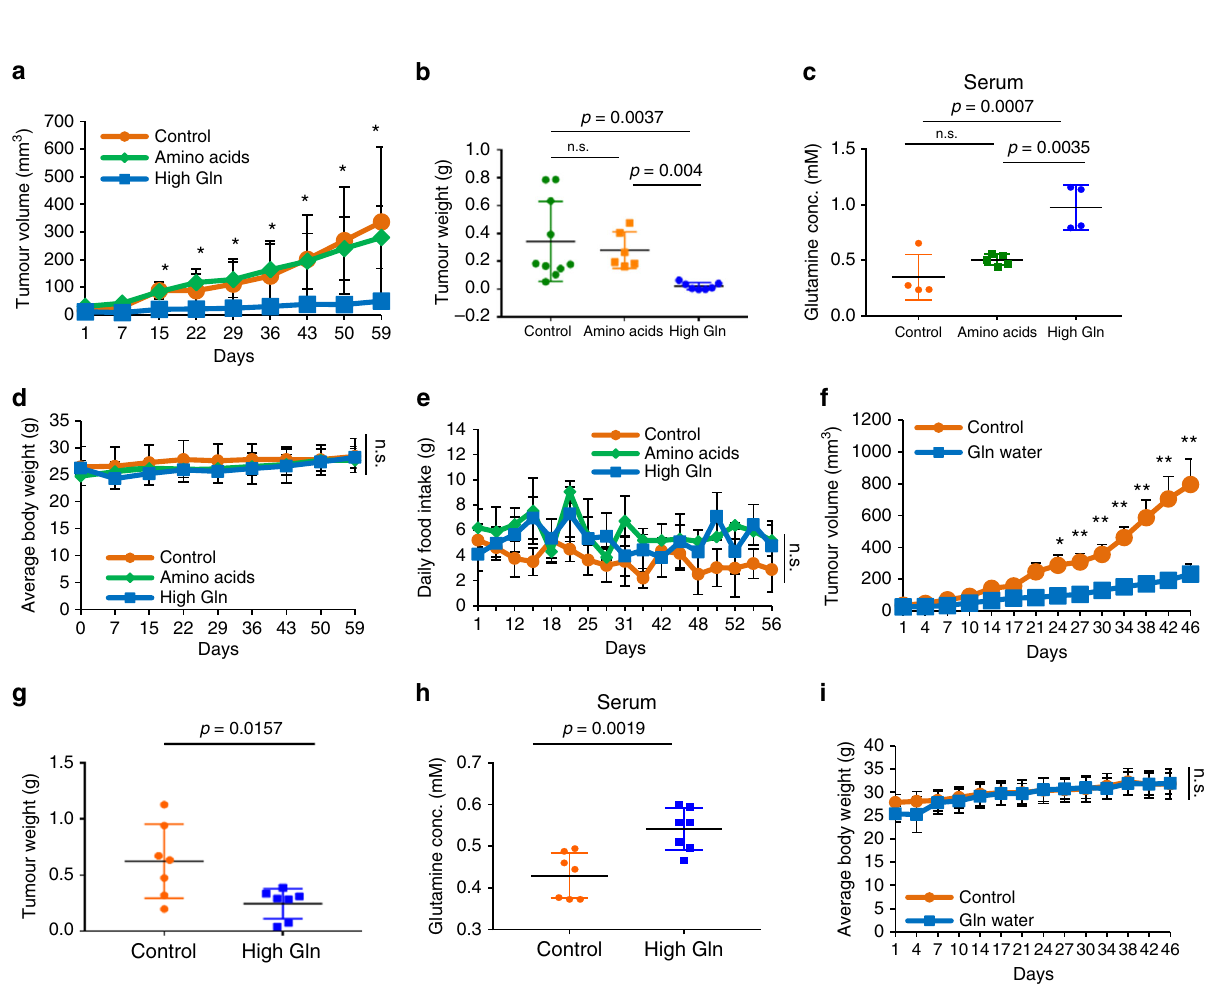
Fig. 2 Increased glutamine is suf fi cient to inhibit melanoma growth. a Nude mice with M229 xenografts received control, amino acids, or high Gln diet. Tumours were measured twice weekly (Control, n = 10; Amino acids, n = 6; High Gln, n = 7). b Tumour weights post mortem (Control, n = 10; Amino acids, n = 6; High Gln, n = 7 biologically independent tumours). c Glutamine concentration in serum measured by EIA Kit (Control, n = 4; Amino acids, n = 5; High Gln, n = 4 biological replicates performed in triplicates). d , e Nude mice with subcutaneous injection of M229 cells receiving control, amino acids, or High Gln diet were weighed in d and monitored for food intake in e (Control, n = 10; Amino acids, n = 6; High Gln, n = 7). f Nude mice with subcutaneous injection of M229 cells placed on regular (control) water or glutamine-supplemented (Gln) water 1 week post injection. Tumours were measured twice weekly (Control, n = 7; High Gln, n = 7). g Tumour weights post mortem (Control, n = 7; High Gln, n = 7 biologically independent tumours). h Glutamine concentration in serum was measured (Control, n = 7; High Gln, n = 7 biological replicates performed in triplicates). i Nude mice with subcutaneous injection of M229 cells placed on control water or Gln water were weighed twice weekly (Control, n = 7; High Gln, n = 7 biologically independent mice). Data represent means and error bars are s.d. a – e p value calculated using one-way ANOVA followed by post hoc Tukey ’ s HSD test. f – i p value calculated by t test (unpaired, two tailed), * p < 0.05, ** p < 0.01, n.s. not signi fi